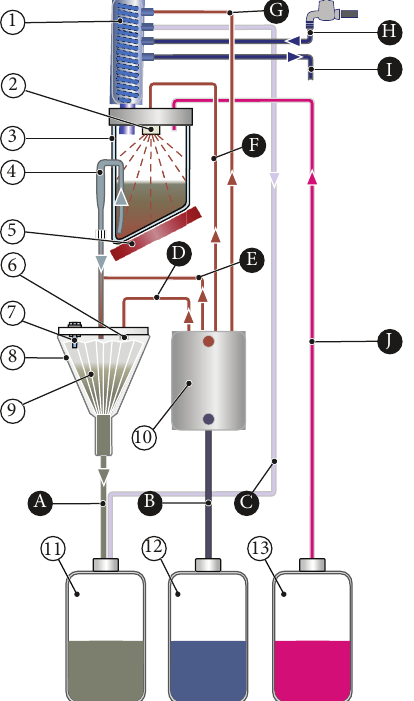
Figure 1: Schematic illustration of the automatic sample hydrolysis process necessary for Weibull-Stoldt fat extraction (reproduced with permission from Gerhardt Analytical Systems). 1 Condenser, 2 shower, 3 hydrolysis beaker, 4 sample transfer device, 5 hotplate, 6 shower for filter, 7 level sensor funnel, 8 funnel, 9 folded filter, 10 hot water generator, 11 tank for sample waste, 12 tank for H 2 O, and 13 tank for HCl, A sample drainage, B distilled water addition, C air ventilation for condenser, D hot water addition-filter moisture, E hot water addition-rinsing sample transfer, F hot water addition- rinsing hydrolysis beaker, G hot water addition-rinsing condenser, H cooling water inlet, I cooling water outlet, J hydrochloric acid